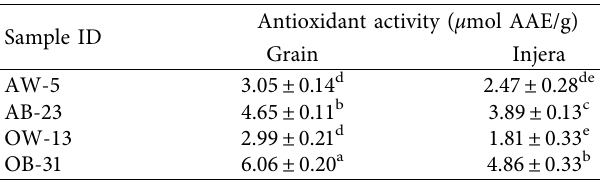
Figure 3: Relationship between ascorbic acid contents and in vitro antioxidant activities of the white and brown tef grains. Table 5: Comparison of the antioxidant activities in the aqueous extract of white and brown tef grains and their injera